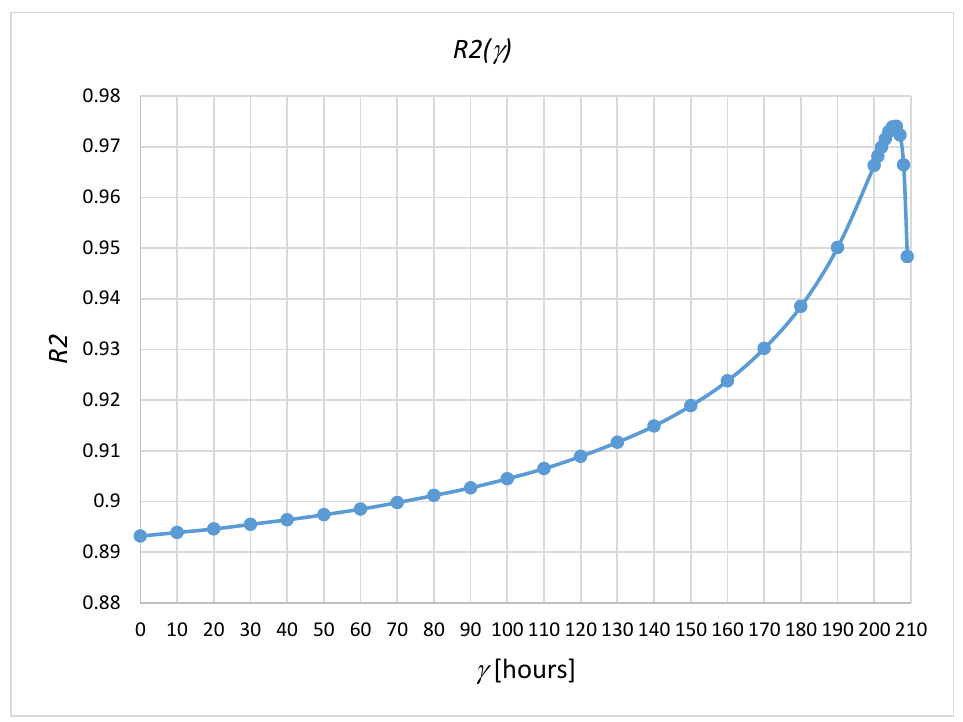
Figure 5. Graph R 2 ( γ ), with the maximum value for R 2 corresponding to the value γ optimum = 206 h.